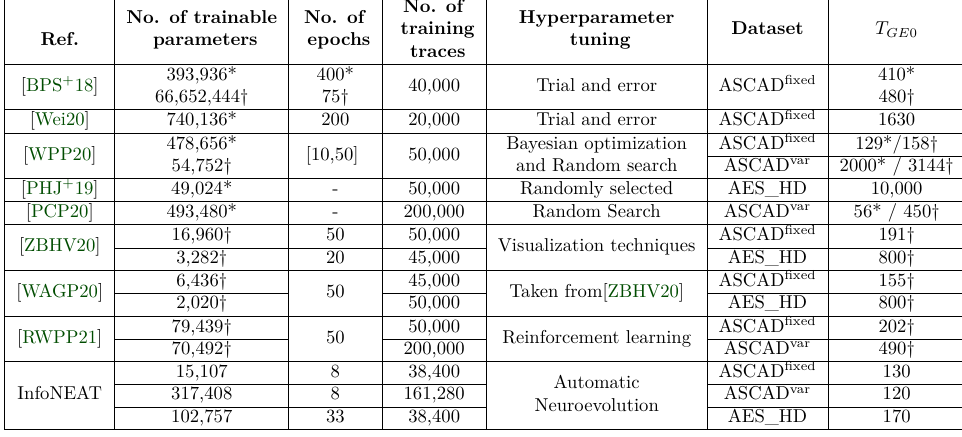
Table 6: SOTA approaches vs.